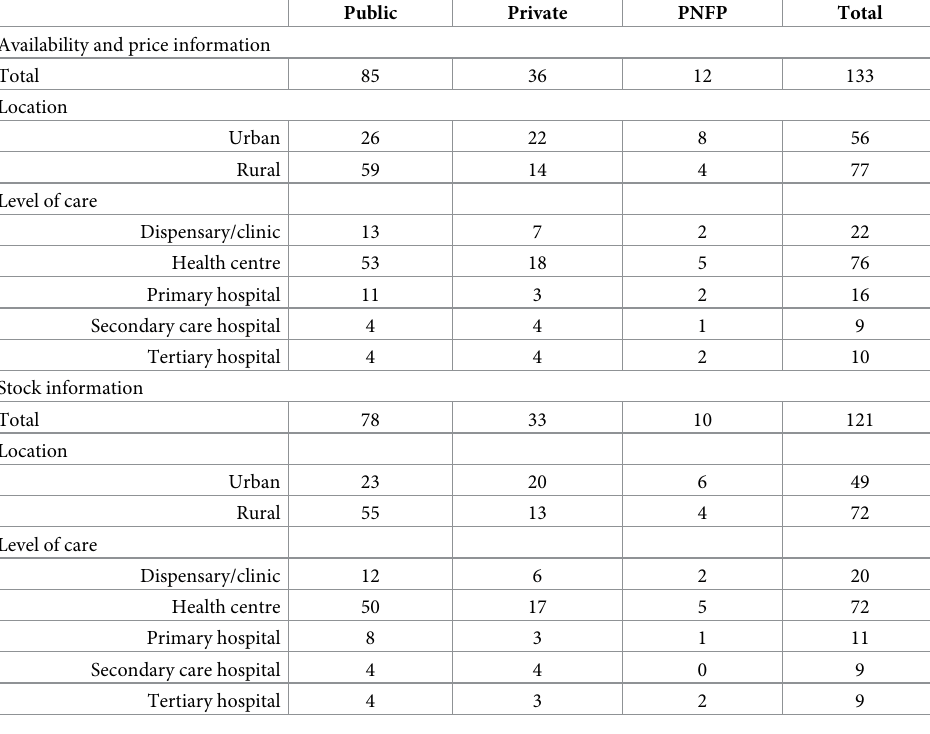
Table 1. Number of surveyed facilities with availability, price and stock information available, by sector, location and level of